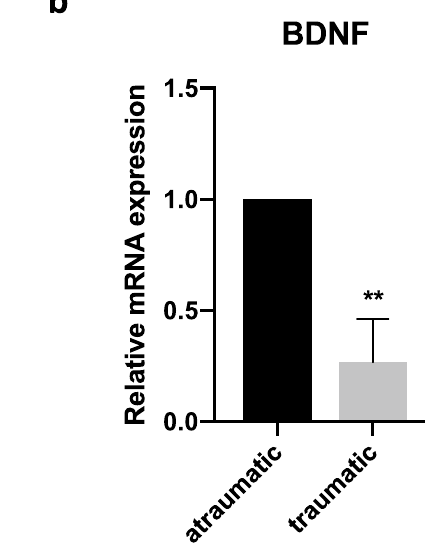
mRNA expression in traumatized muscle tissue by qRT-PCR. ** p < 0.01, two-tailed Student’s t -test with n = 3 biological replicates, error bars are